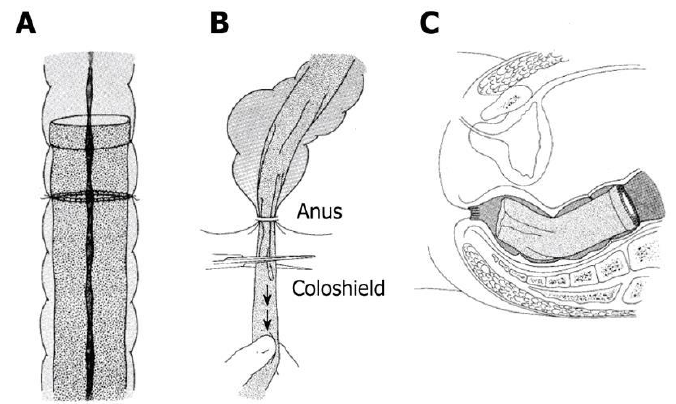
Figure 5. The coloshield, reprinted with permission from the Baishideng Publishing Group under CC BY-NC 4.0 [53]. ( A ) The coloshield is sutured to the submucosa of the bowel proximal of the anastomosis; ( B , C ) Slight traction is placed on the coloshield and it is cut so that it lies in the rectal ampulla.